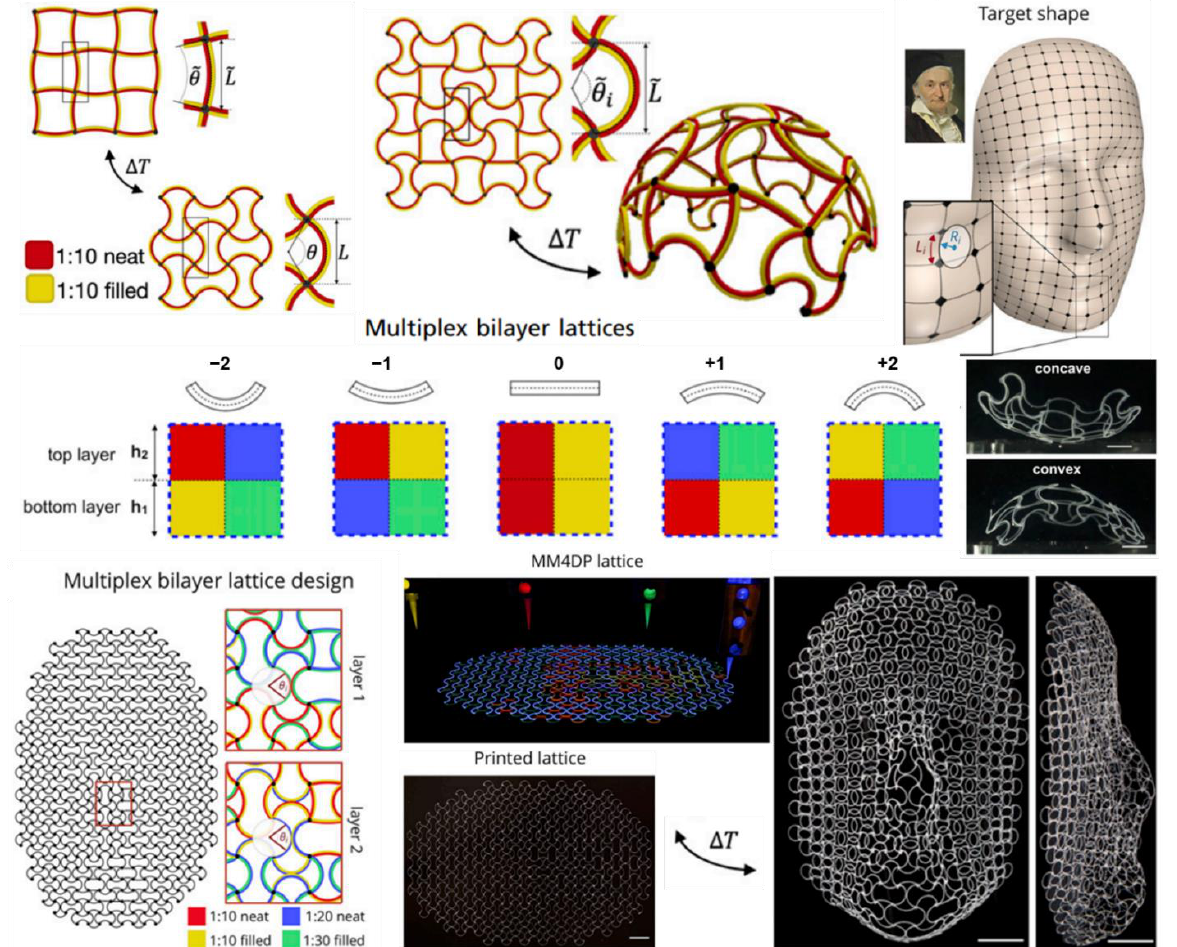
Figure 7. Multi materials lattice printing, where the elasticity and thermal expansion coefficient for the printed lattice is precisely tuned to obtain the final desired form of the printed structure using temperature as external stimulus. Adapted with permission from [132] . Copyright © 2019 PNAS.